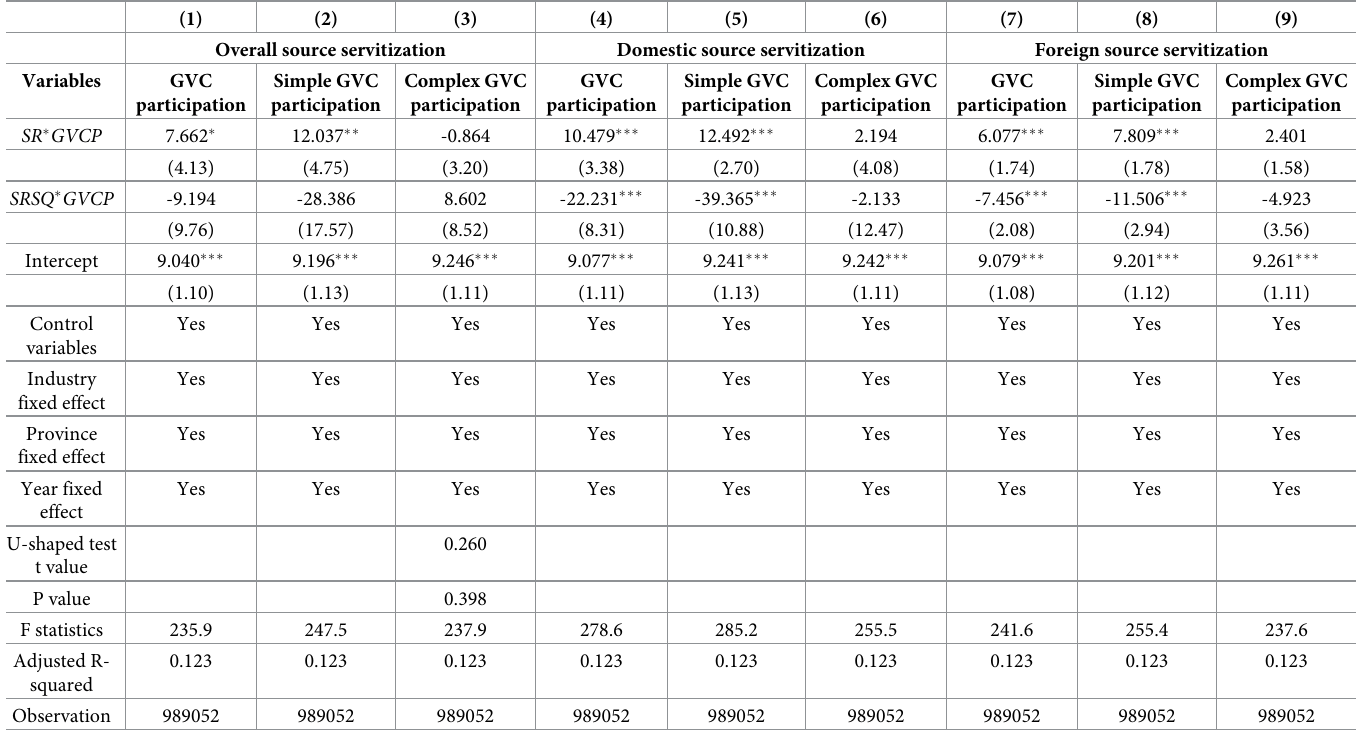
Table 9. The results of the moderating effect of GVC participation on the impact